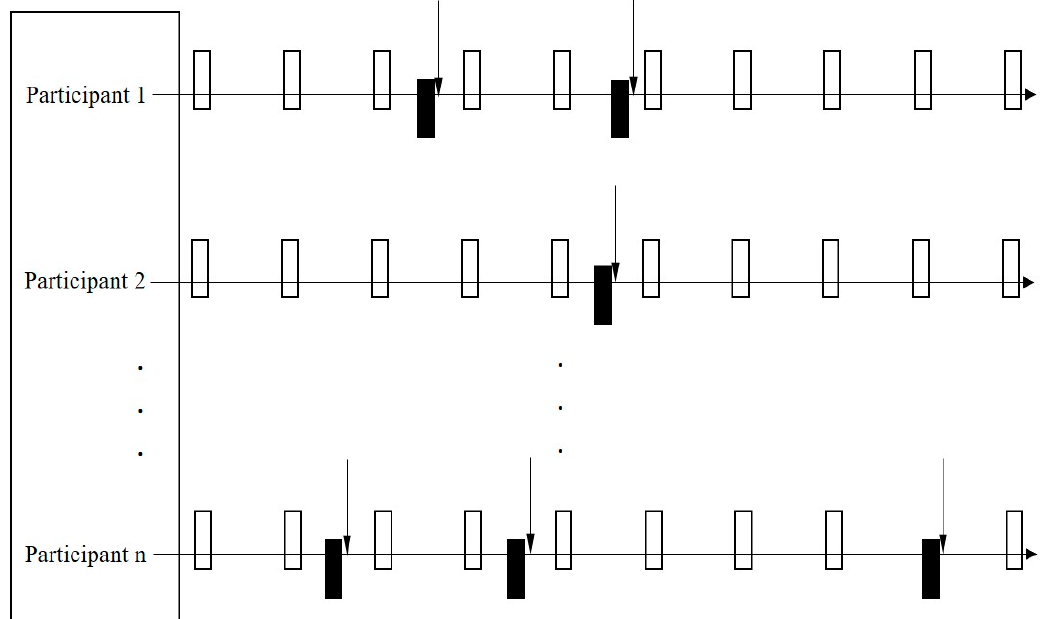
Figure 1. Case crossover study design (m:n matched). Each participant was followed up for 90 days. represents every control period; represents every case period; represents every pain exacerbation report time point.